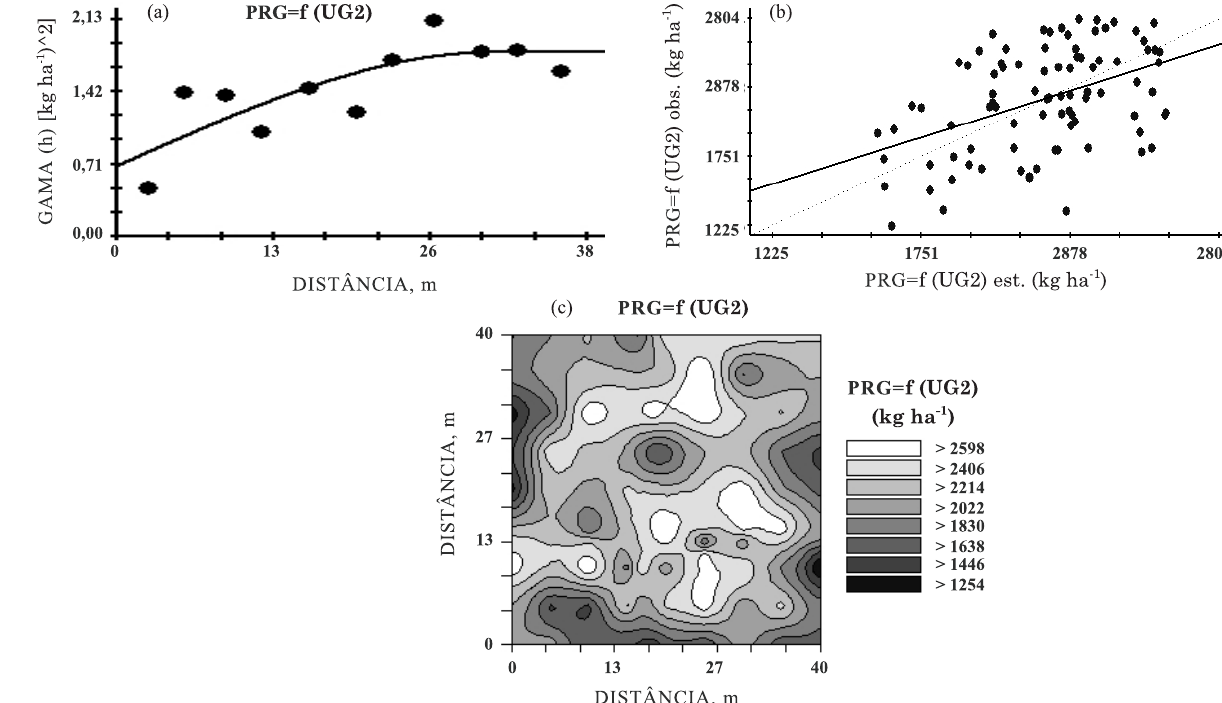
Figura 3. Componentes geoestatísticos da produtividade do feijão em função da UG2 de um Latossolo Vermelho distroférrico de Selvíria